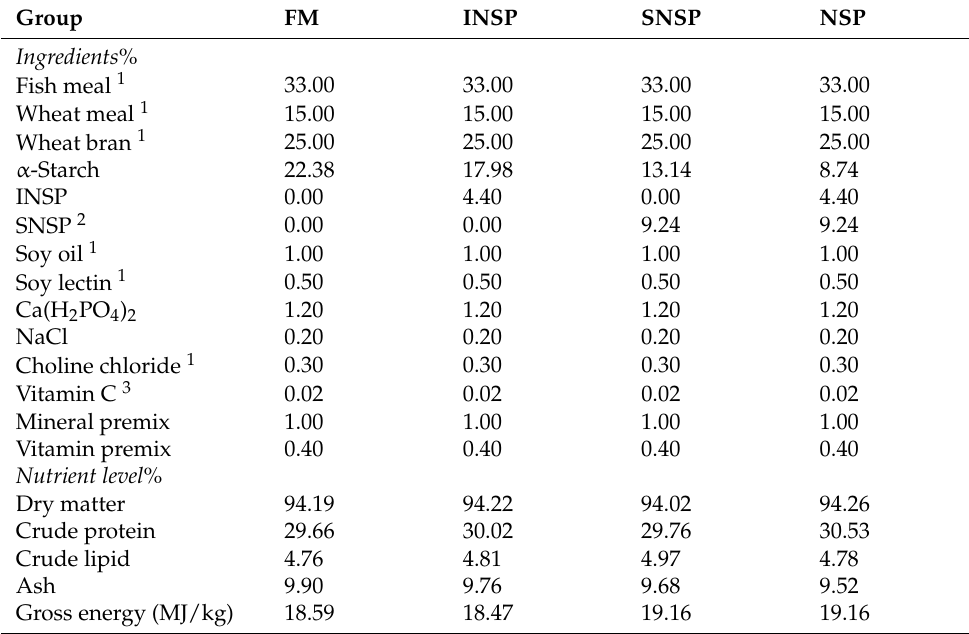
Table 1. Formulation and nutrient level of test